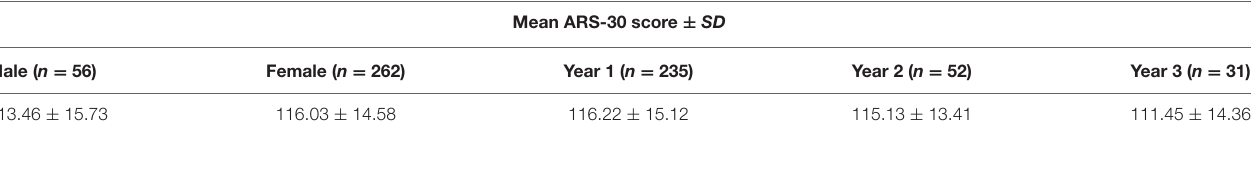
TABLE 8 | Mean ARS-30 scores by gender and year of